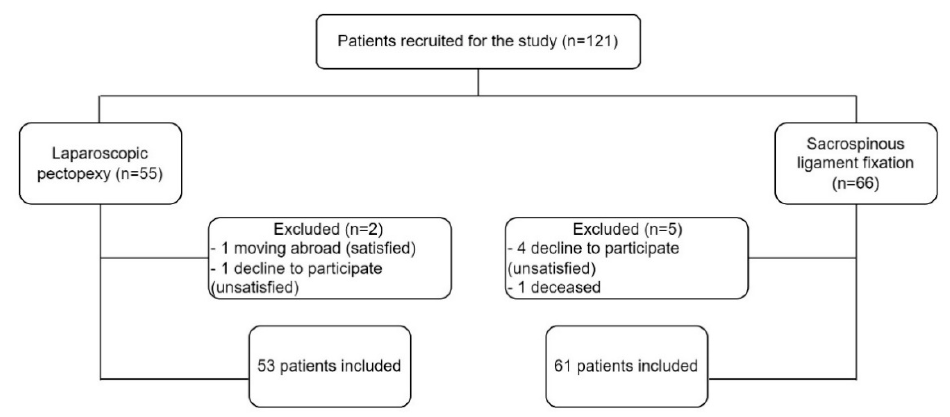
Figure 1. Study flowchart.